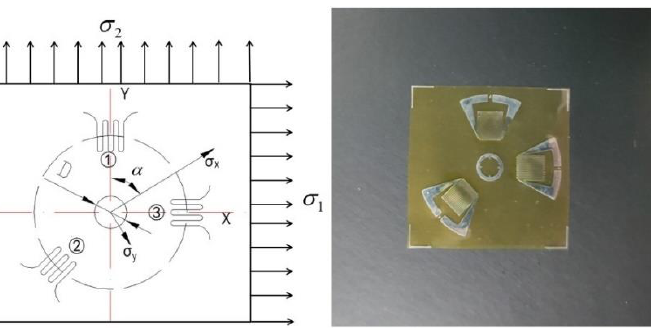
Figure 1. Electroslag strip cladding test plate.